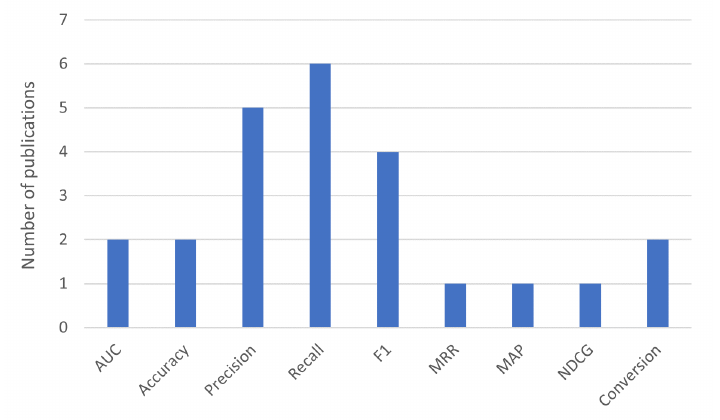
Figure 2. Evaluation measures in housing